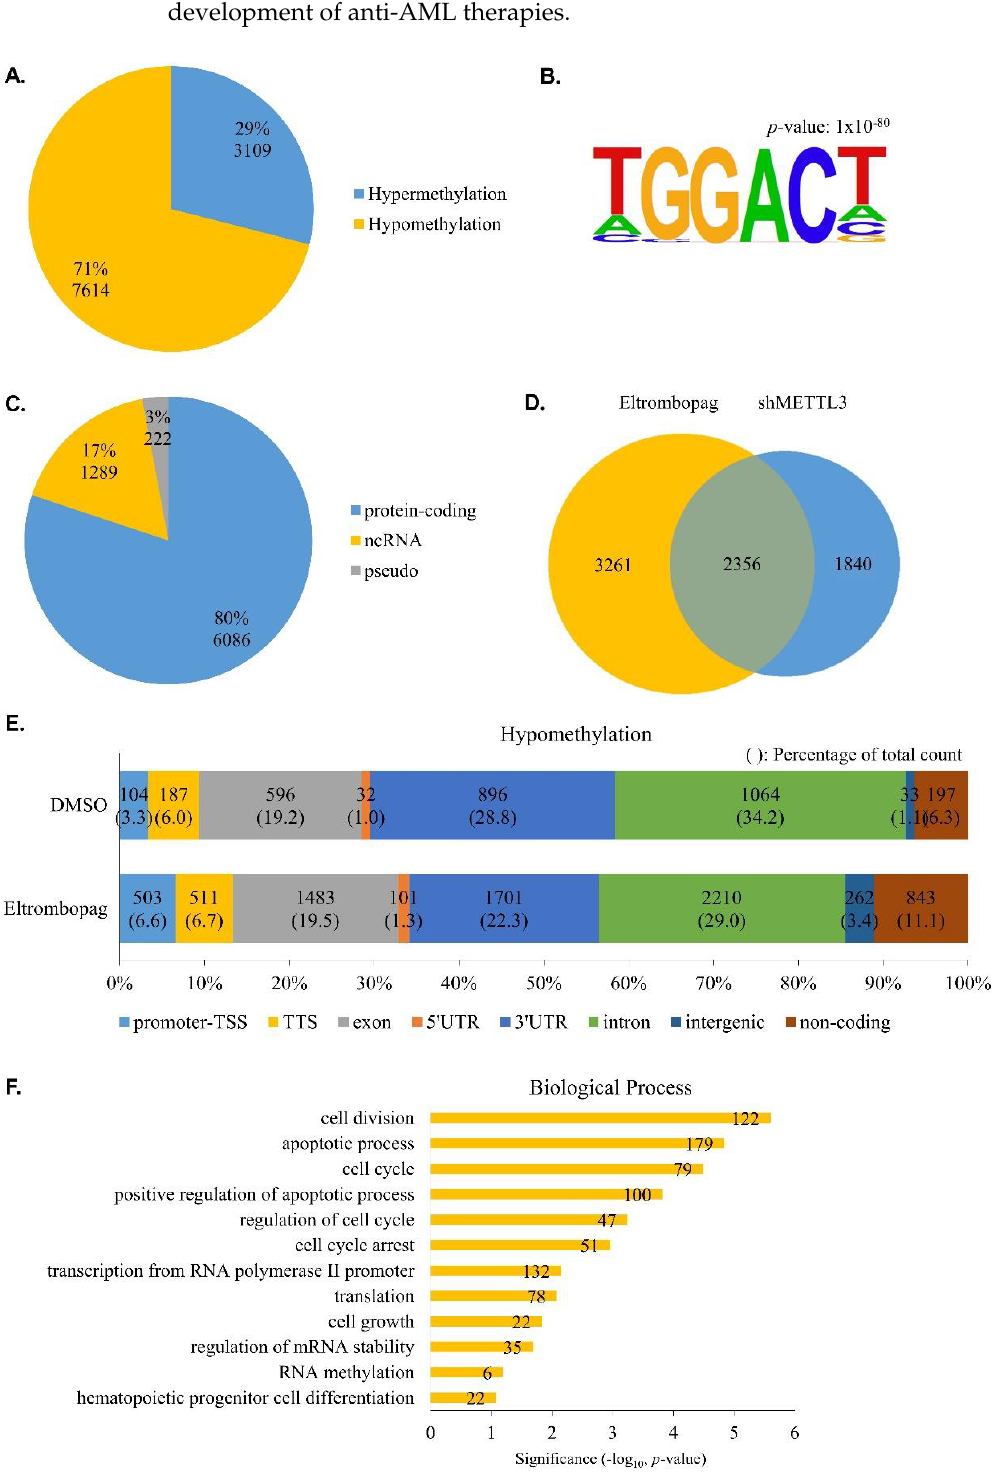
Figure 9. Eltrombopag reduces m 6 A levels in AML cells. ( A ) Distribution of significantly differentiated m6A methylated peaks detected in MOLM-13 cell line with 25 µ M of eltrombopag. If diff.log2.fc is larger than 0 it is indicated as hypermethylation (blue), and if smaller than 0 it is indicated as hypomethylation (yellow). ( B ) Top consensus motif in eltrombopag-treated differentiated m 6 A methylated peaks with HOMER. GGAC, a subset of the m 6 A common motif, was detected. ( C ) Distribution of hypomethylated gene identity. Protein-coding, non-coding RNA (ncRNA), and pseudogenes (pseudo) are shown in blue, yellow, and gray, respectively. ( D ) Common and unique